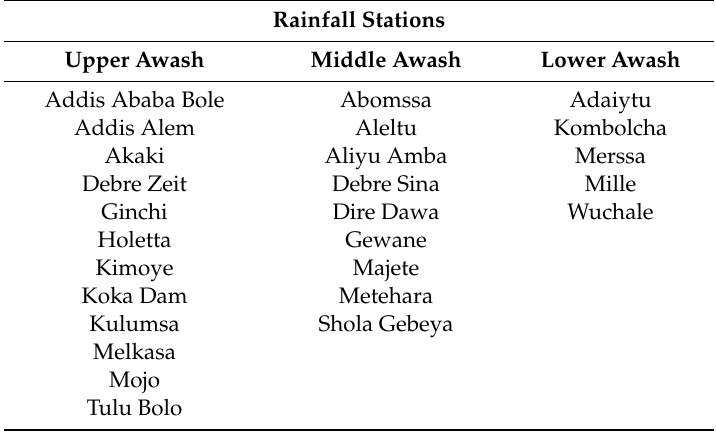
Table A1. Location of Rainfall stations in Awash River Basin.